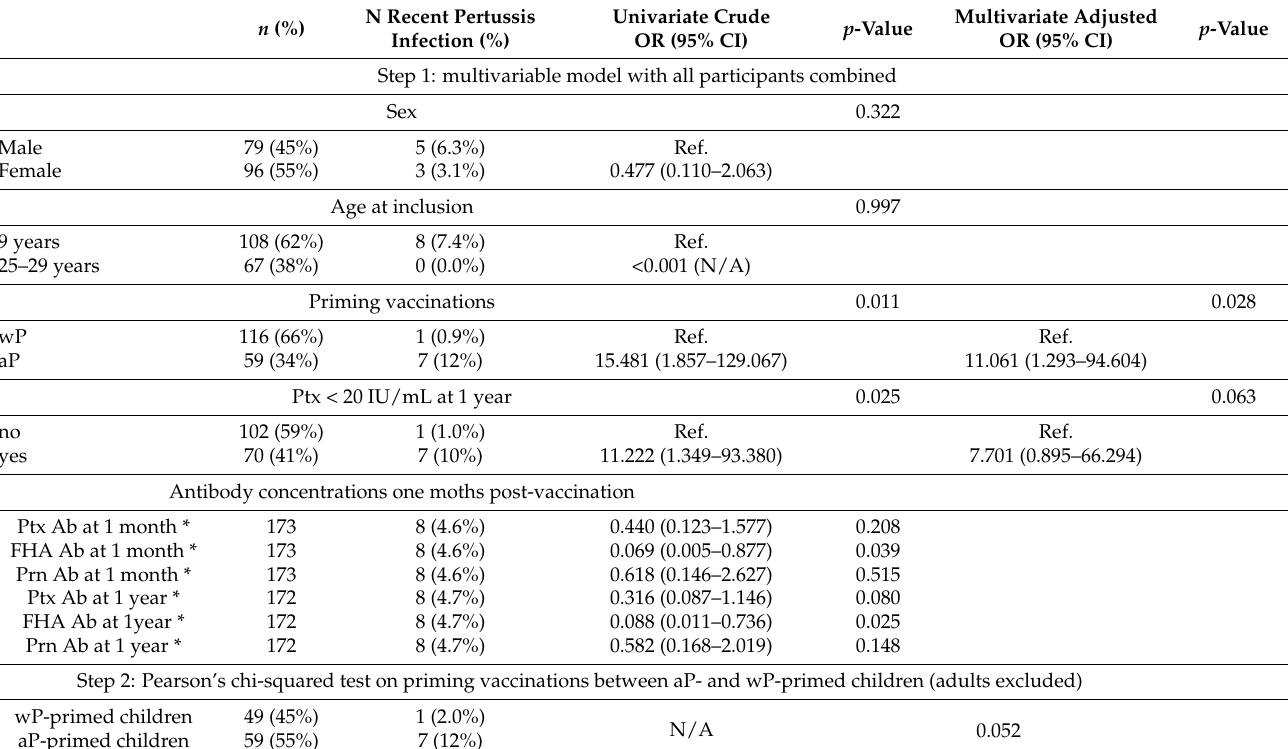
Table 2. Risk factors for contracting